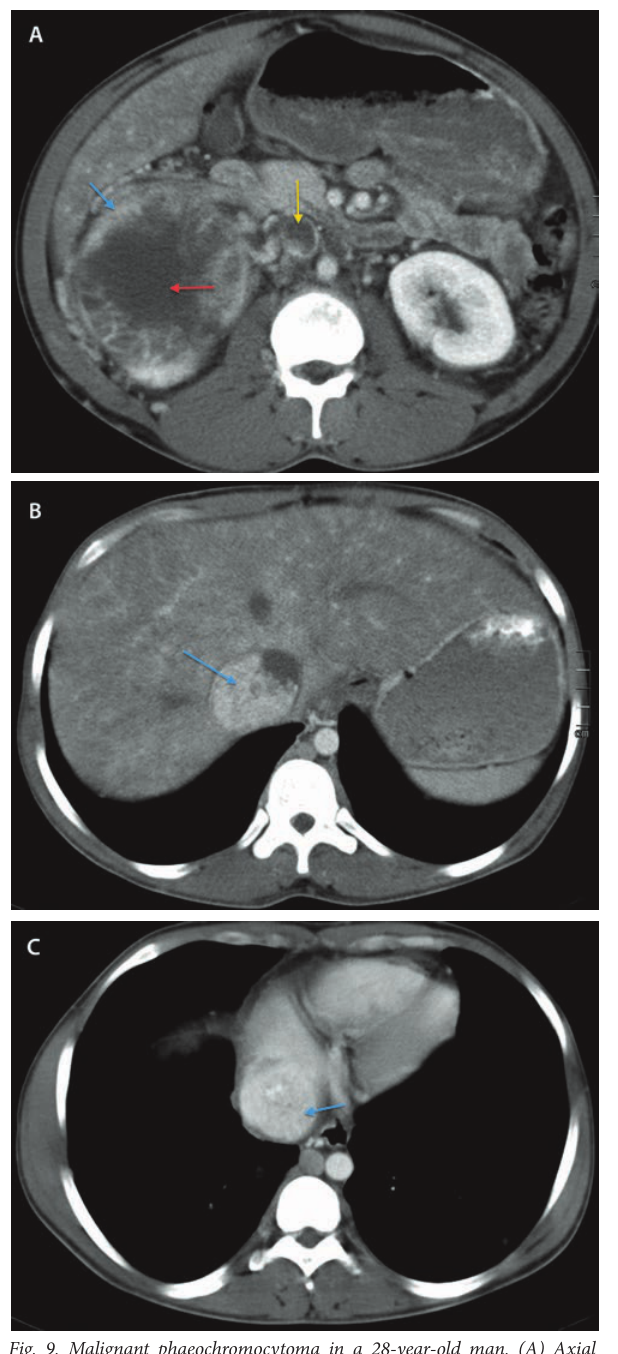
Fig. 9. Malignant phaeochromocytoma in a 28-year-old man. (A) Axial postcontrast CT scan demonstrates a large phaeochromocytoma (blue arrow) with central necrosis (red arrow) and invasion into the IVC (yellow arrow). Enhancing tumour thrombus is noted to expand the intrahepatic IVC (blue arrow in B) and extend into the right atrium of the heart (blue arrow in